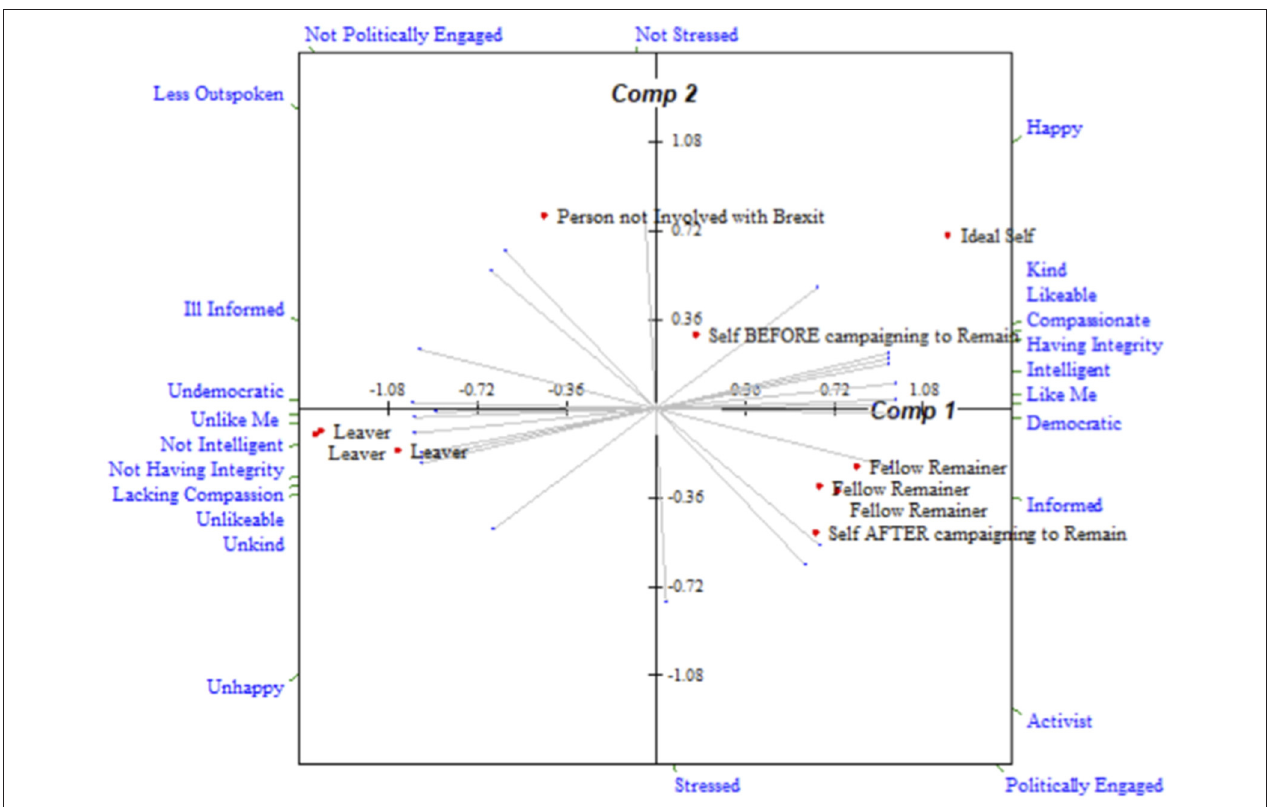
FIGURE 4 | Plot of elements in construct space for Remain average